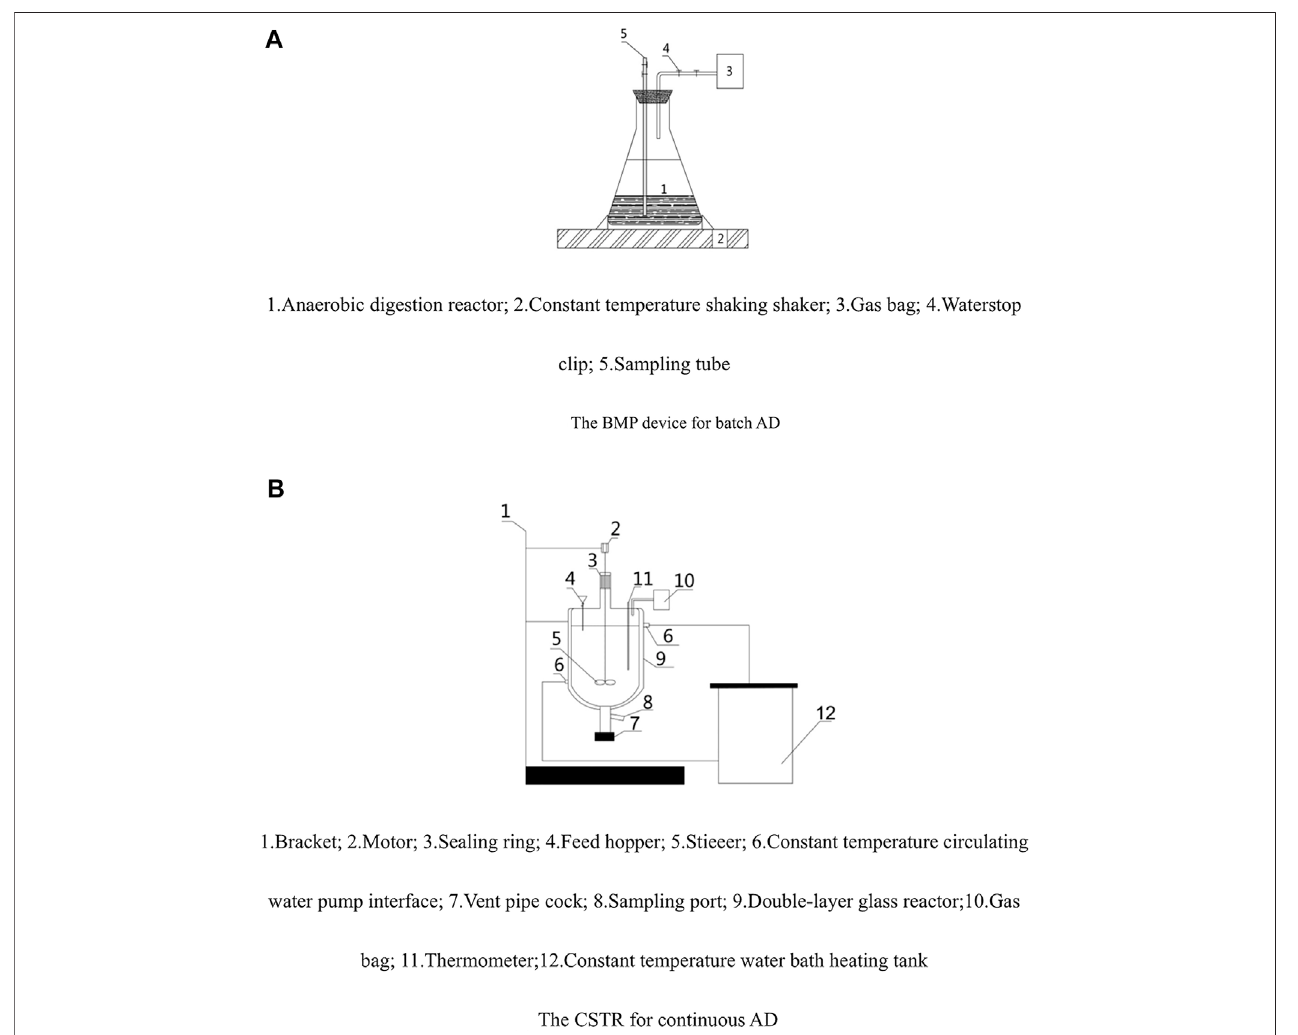
FIGURE 1 | Diagrams of the experimental devices for (A) batch and (B) continuous AD. (A) The BMP device for batch AD and (B) the CSTR for continuous AD.